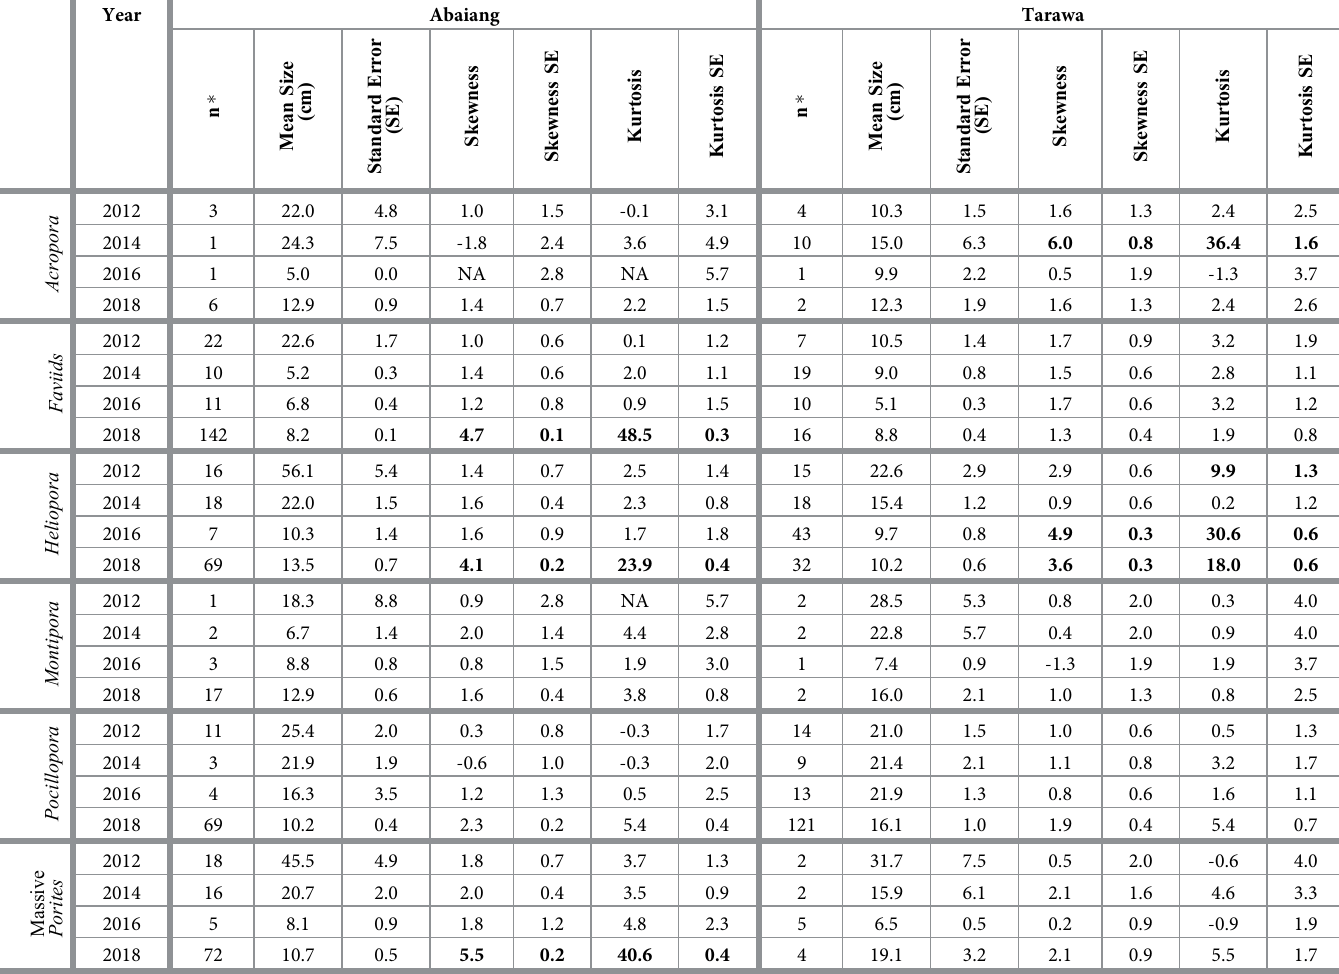
Table 4. Size-frequency statistics for key coral taxa. Skewness and kurtosis values that are significantly different from normal (greater than two times the standard error) are in